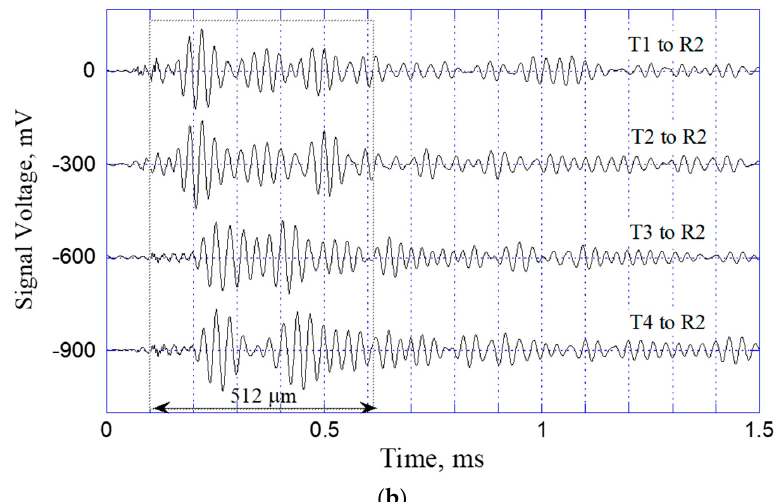
Figure 4. Signal waveforms of Lamb waves launched by T1, T2, T3, and T4, respectively, and received at transducers ( a ) R1 and ( b ) R2.